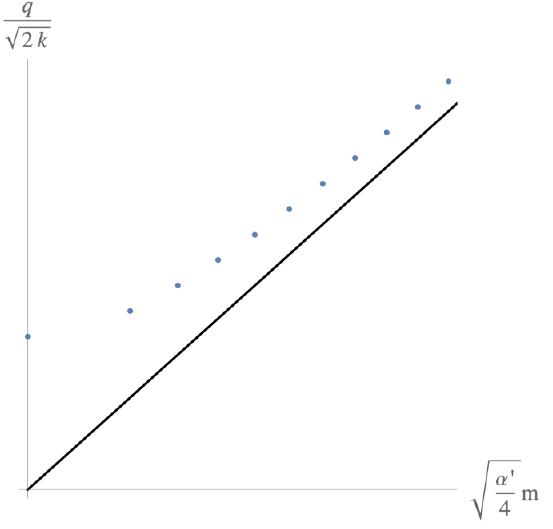
q q 2 (cid:0) 1 is preserved. At large mass, string states k(cid:11) 0 m